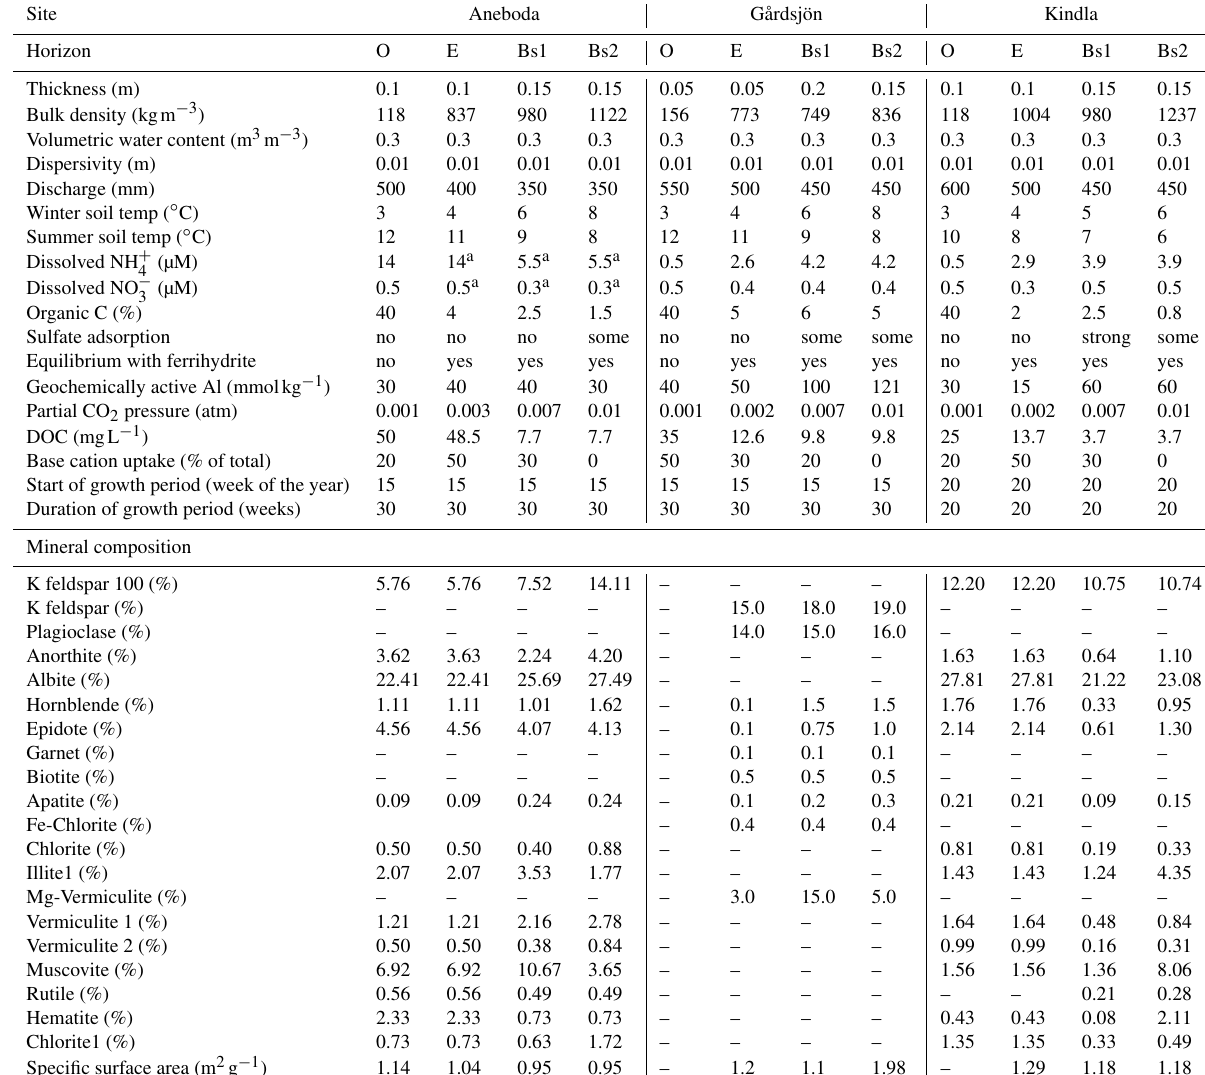
Table 1. Parameter values and assumptions used for the HD-MINTEQ simulations of all three sites. Site Aneboda Gårdsjön Kindla